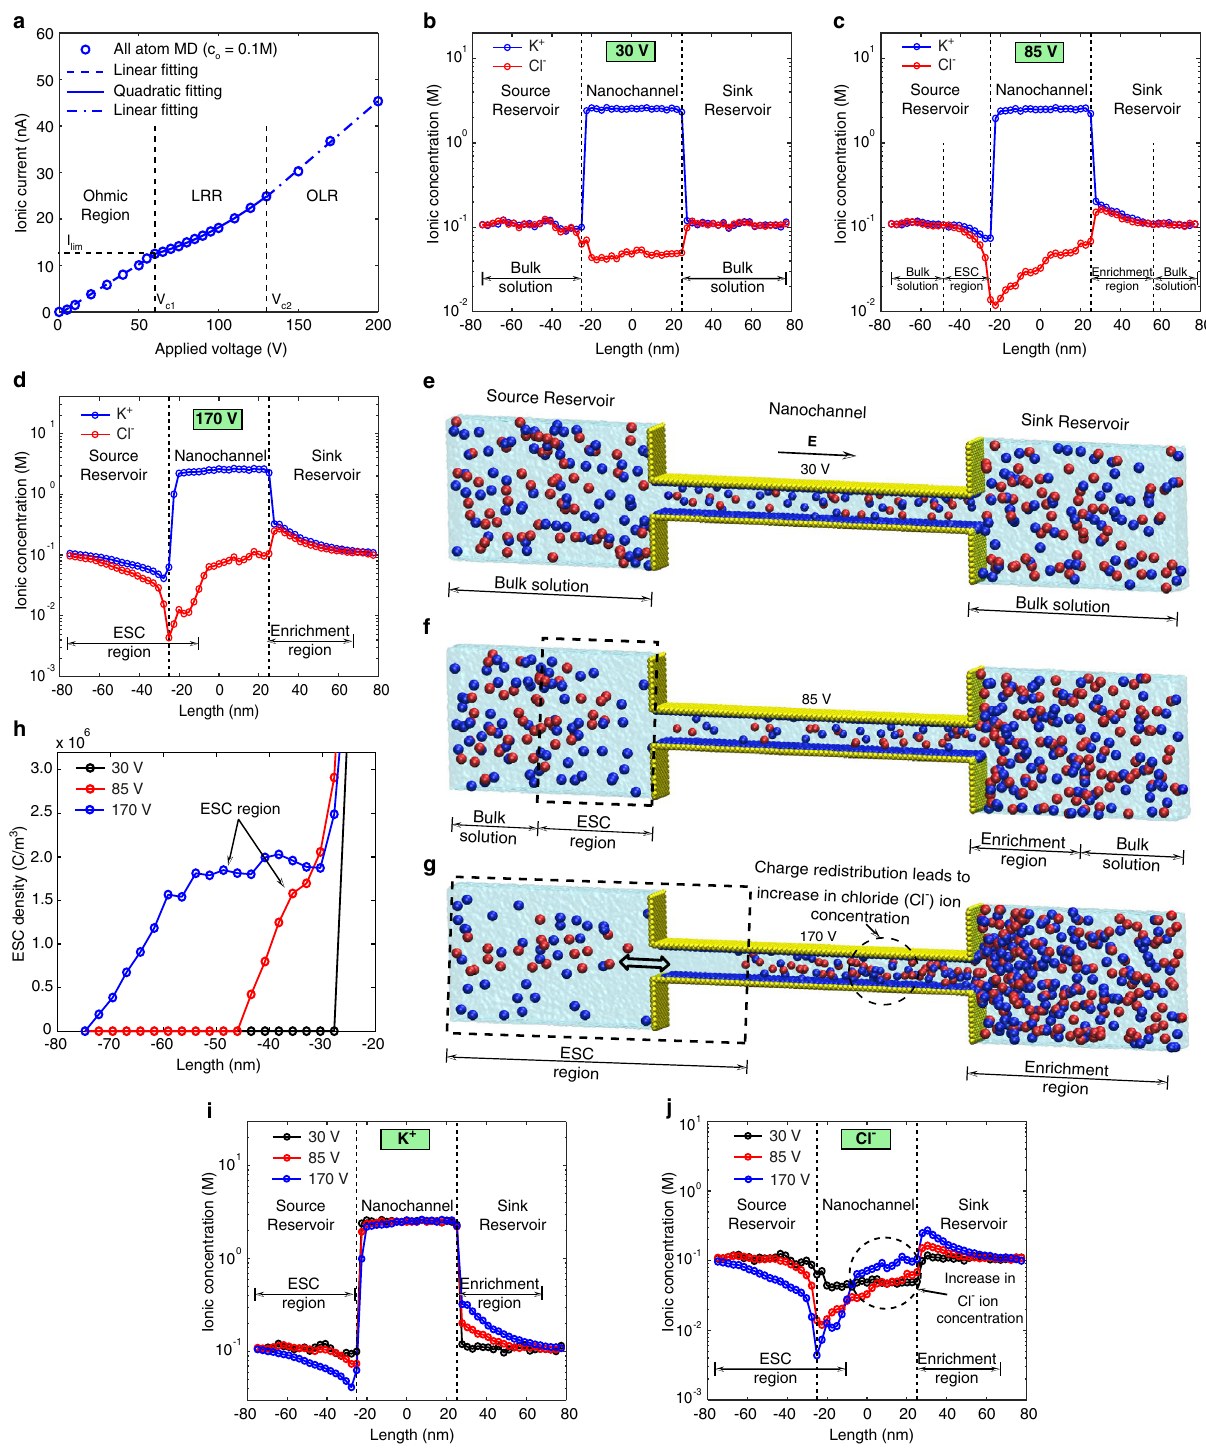
Figure 2. ( a ) reveals the nonlinear I–V characteristics of the system from all-atom MD simulations. It is divided into three regions, similar to experiments, namely, Ohmic region, limiting resistance region (LRR), and overlimiting resistance region (OLR). ( b–d ) shows the concentration distribution of ions along the length of the system for all three regions, corresponding to the applied voltage of 30V, 85V, and 170V respectively and ( e–g ) shows corresponding snapshots from the all-atom MD simulations. For clear visualization we shown only ions inside the system within a range of x = -1.0 to 1.0 nm and z = -59 to z = 59 nm. Also, the arrow shows the direction of propagation of the ESC region. Semitransparent surface indicates the volume occupied by the water molecules. ( h ) shows the variation of the ESC density inside the source reservoir. ( i–j ) shows the comparison of the concentration distribution of potassium ( K + ) and chloride ( Cl − ) ions in all three regions, respectively. Drawings in ( e – g ) were created using VMD software (www. ks. uiuc. edu/ Devel opment/ Downl oad/ downl oad. cgi? Packa geName= VMD and version